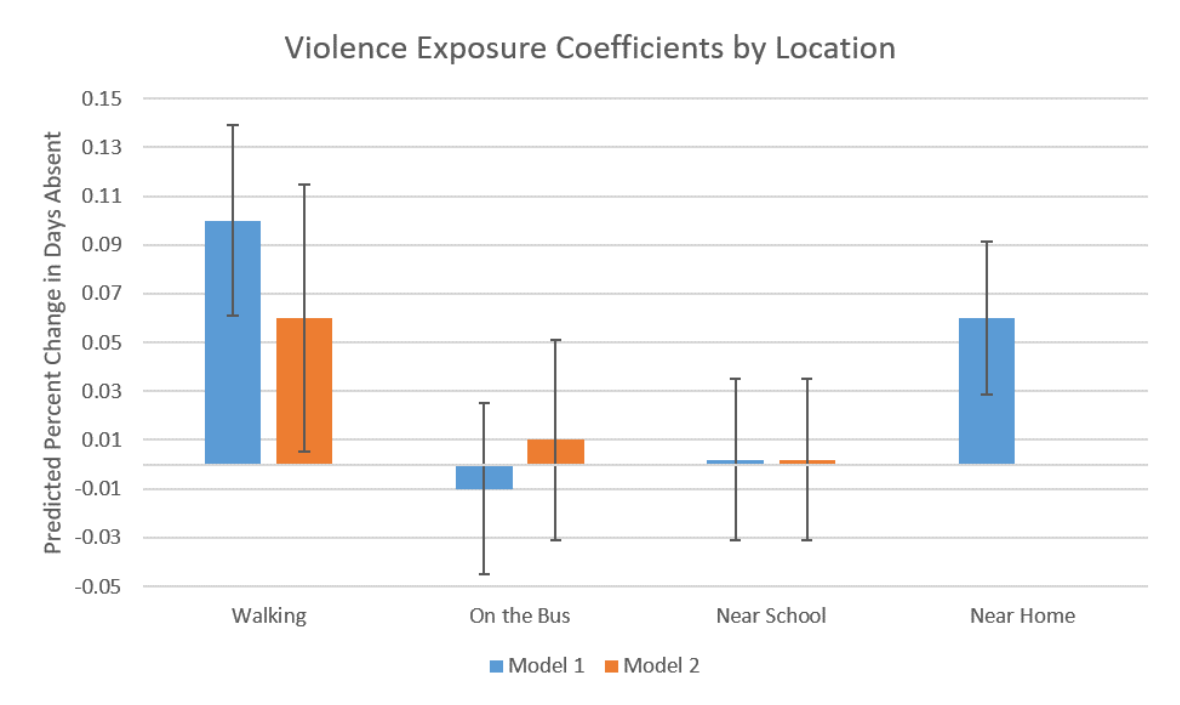
Figure 5: Predicted percentage change in days absent by location of exposure to violent crime. There were 4,187 observations: model 1 R 2 0.33, model 2 within R 2 0.33, between R 2 0.49, overall R 2 0.36. All measures of days absent and crime exposure have been transformed using the inverse hyperbolic sine function and can be interpreted as a percentage change. All models include last year’s days absent, total travel time, number of stops, an indicator for walking only, gender, race, special programs eligibility, and whether students attend selective or vocational schools. Model 2 includes school-choice indicators and neighborhood fixed effects. See Appendix B in the online supplement for complete models. Source : Authors’ calculation is based on data from the Baltimore Police Department, the Maryland Transit Administration, and the Baltimore City Public